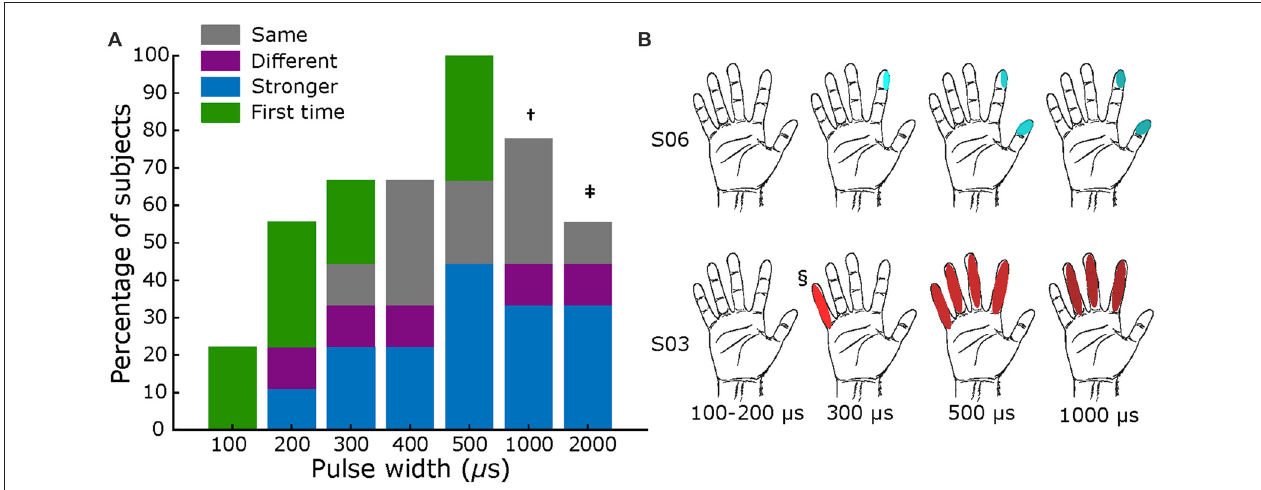
FIGURE 5 | Pulse width mapping. (A) Percentage of subjects that reported sensations across tested pulse widths. Blue section shows fraction of reports of stronger sensation, purple section represents fraction of different sensations or different sensory field, green sections show if it was the first time feeling a percept, and gray section shows those were sensation was the same. All comparisons are with previous lower value. Total subjects: nine, fixed current amplitude = 2–3 mA, and fixed frequency = 50 Hz († value tested in six subjects; ‡ tested in five subjects). (B) Exemplar receptive fields for S03 and S06, darker shades represent a stronger sensation. Main elicited sensations were “pressure” for S06, and “electricity” for S03. §Sensation different from main: feeling of movement.